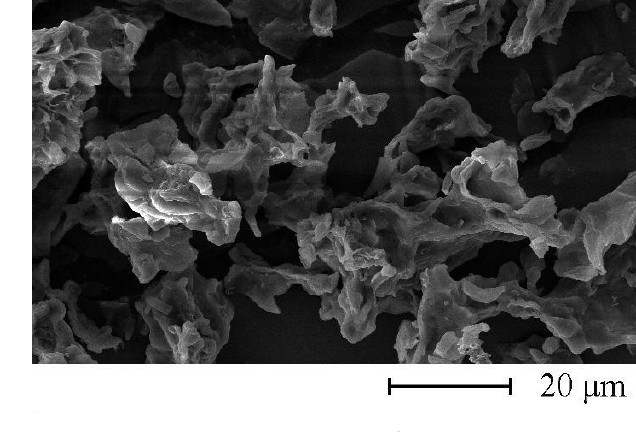
Figure 8. SEM image of GO-POM.